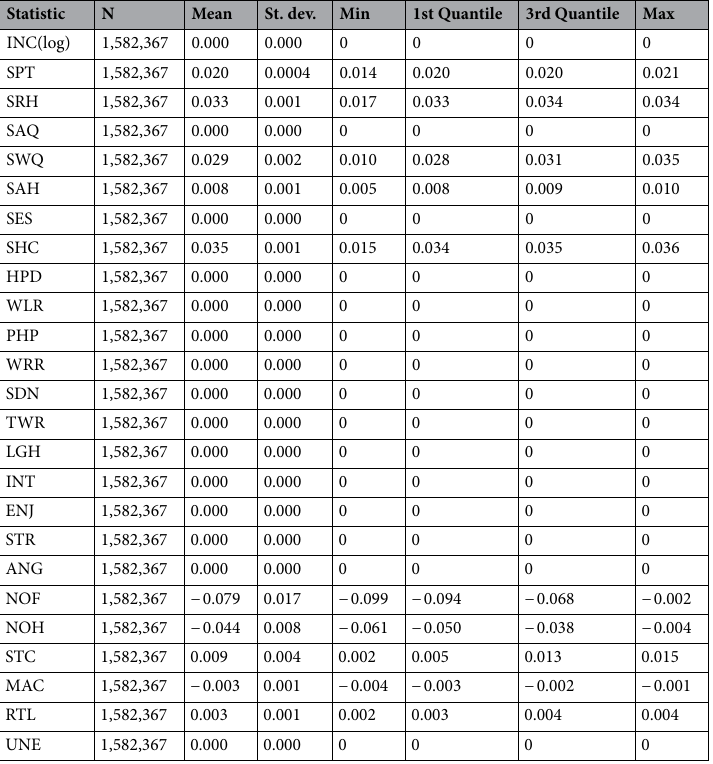
Table 2. The cumulative effects of income on each variable affecting life